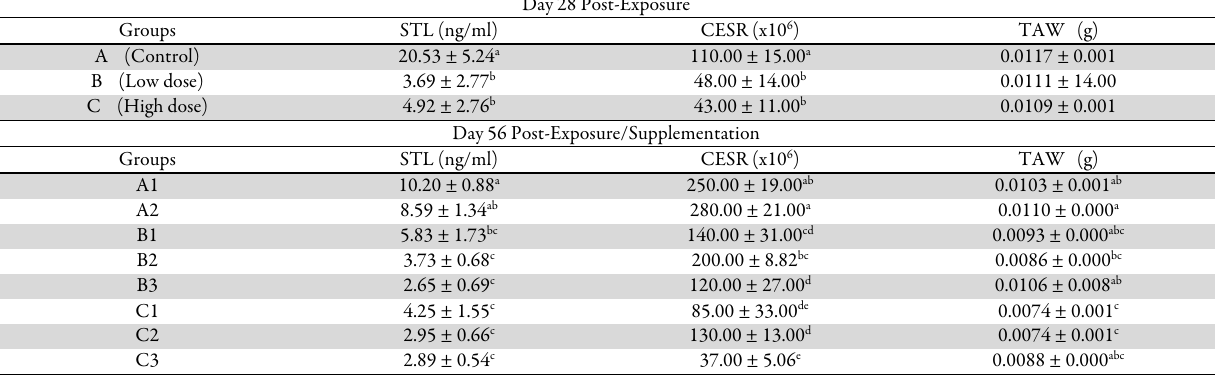
Table 1. Effects of Vitamin E supplementation on serum testosterone level (STL), cauda epididymal sperm reserve (CESR) and testicular allometric weight (TAW) in male rats with crude oil-induced reprotoxicity